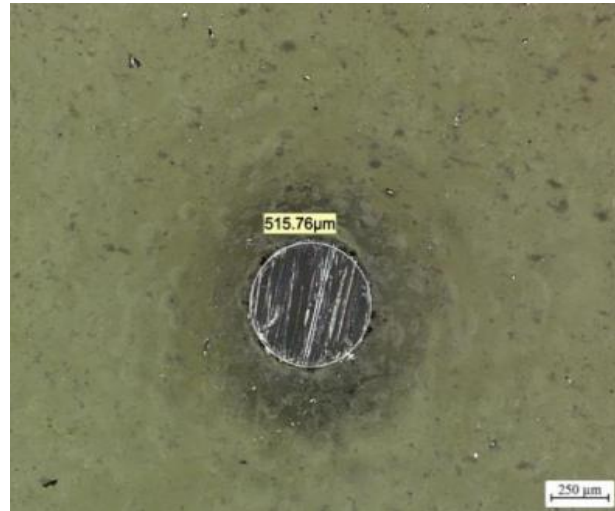
Figure 8. Morphology of a single abrasive grain after dressing.